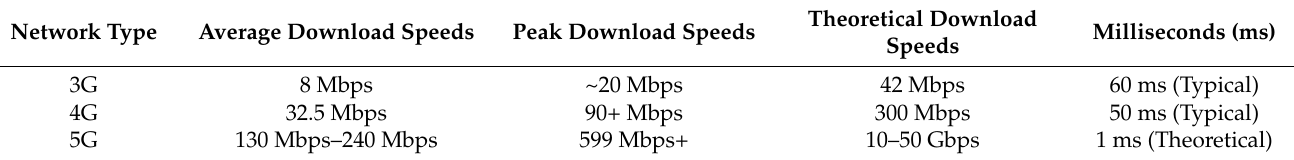
Table 3. Comparison of 3G/4G and 5G latency times and data speeds